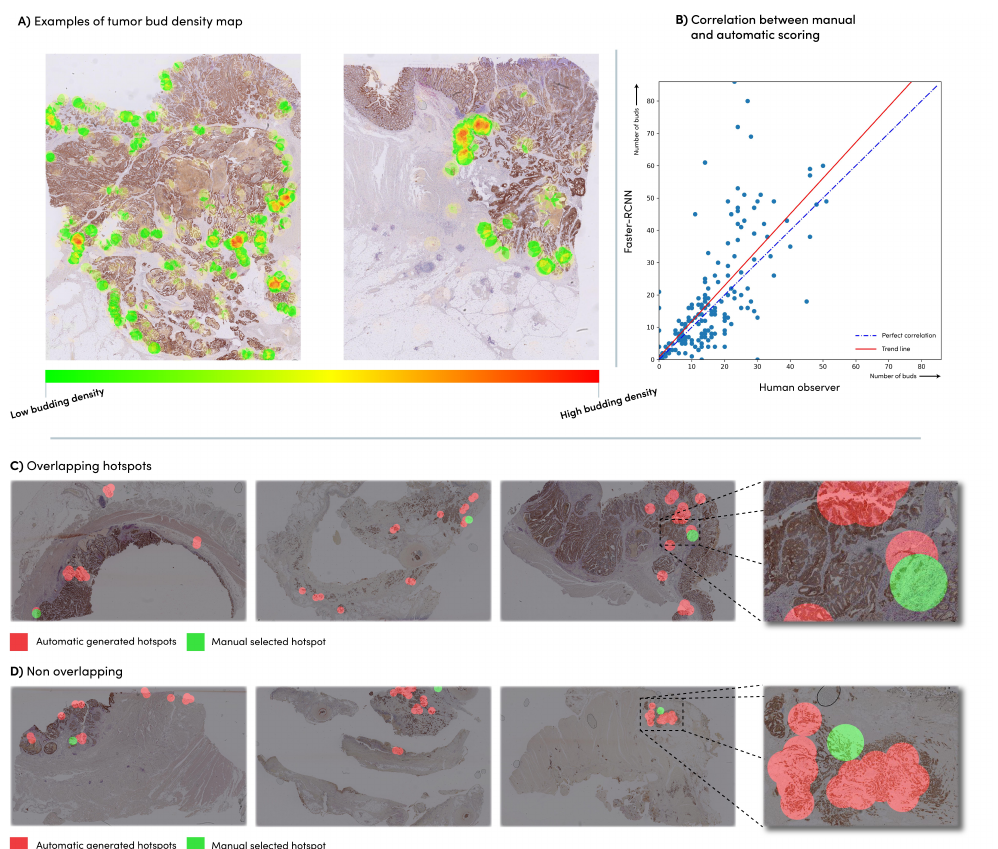
Figure 5. ( A ) Examples of a density heatmap generated based on the automatic tumor bud detections; ( B ) correlation between the manual tumor bud counts in the manual hotspot and the automatic count in the same hotspot; ( C ) Manually selected hotspots (green) vs. automatic hotspots (red). ( A ) cases with overlap; and ( D ) cases with no